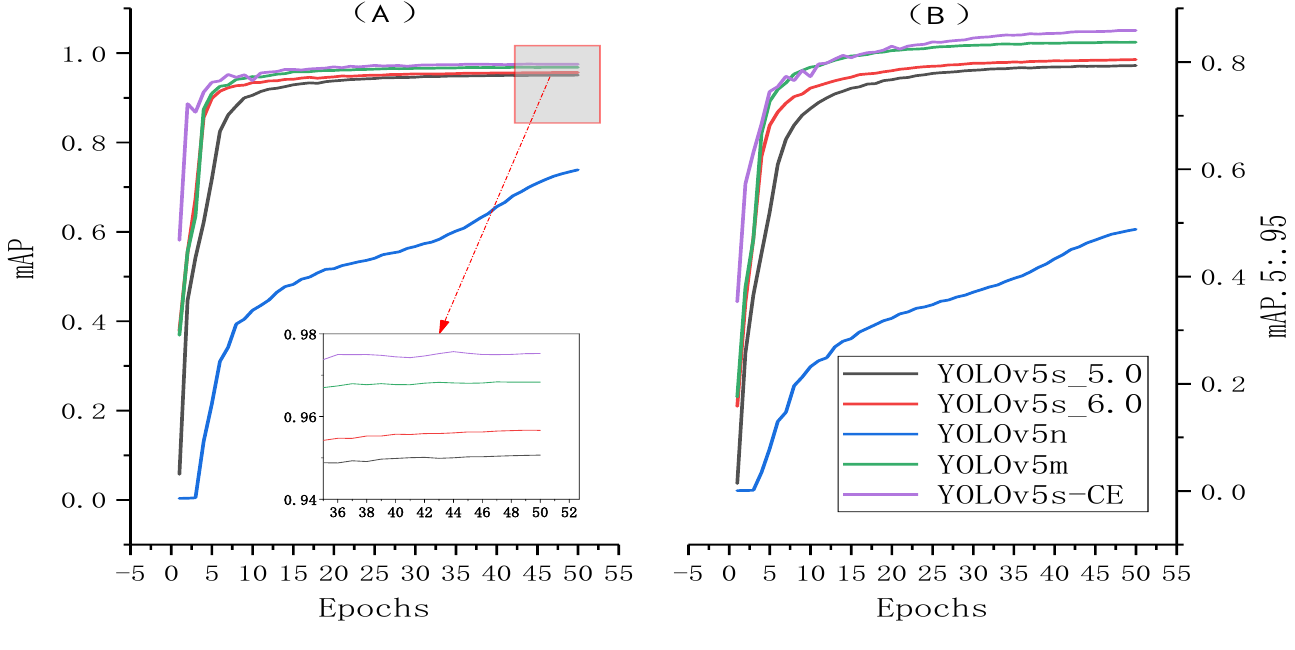
Figure 6. The accuracy comparative results of the YOLOv5n, YOLOv5s, YOLOv5m and YOLOv5s- CE at different IoU thresholds. ( A ) mAP (mean Average Precision) : IOU = 0.5 ( B ) mAP.5:.95 : IOU = 0.5~0.95 (stride = 0.05).